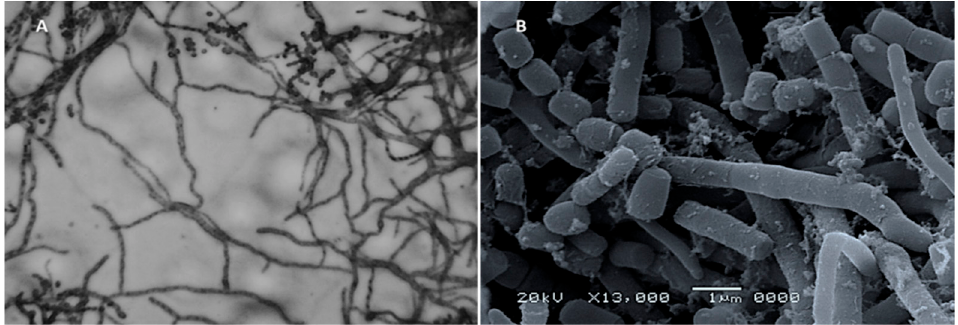
Figure 4. ( A ) Spore chain ‐ bearing hyphae of the isolate MK ‐ 104 under light microscopy (×600); ( B ) Spore chain and spore morphology under scanning electron microscopy (×13,000).